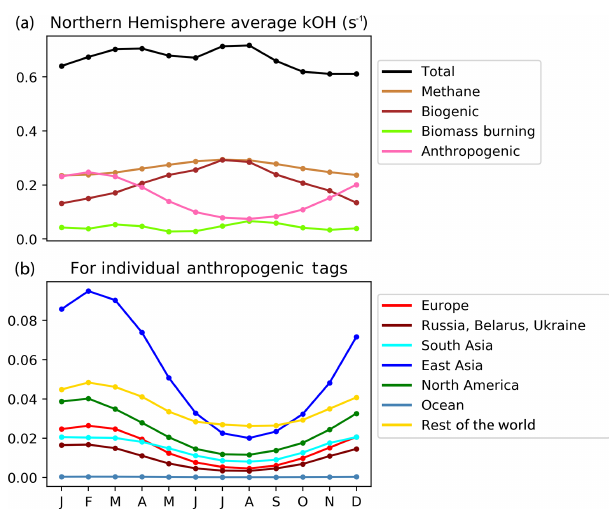
Figure 11. Seasonal cycle of Northern hemispheric tropospheric column-integrated OH reactivity (s − 1 ) due to reactive carbon from the VOC-tagged run. The complete attribution is shown in panel (a) , and the detailed attribution to anthropogenic emissions from HTAP Tier 1 source regions is shown in panel (b)